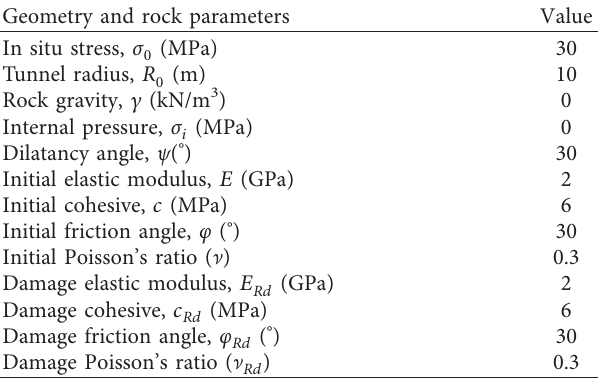
Table 1: The geometry and rock parameters by Pan et al. [30]. Geometry and rock